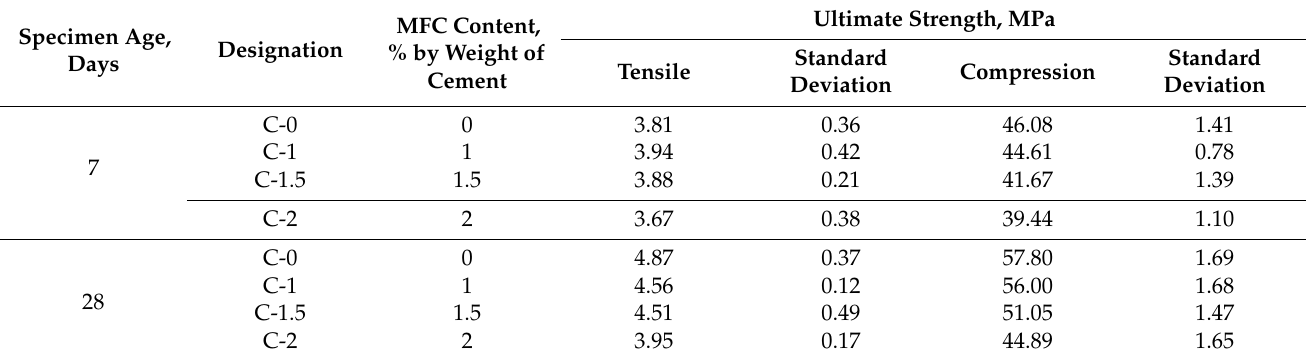
Table 4. Test results of specimens for strength in compression and